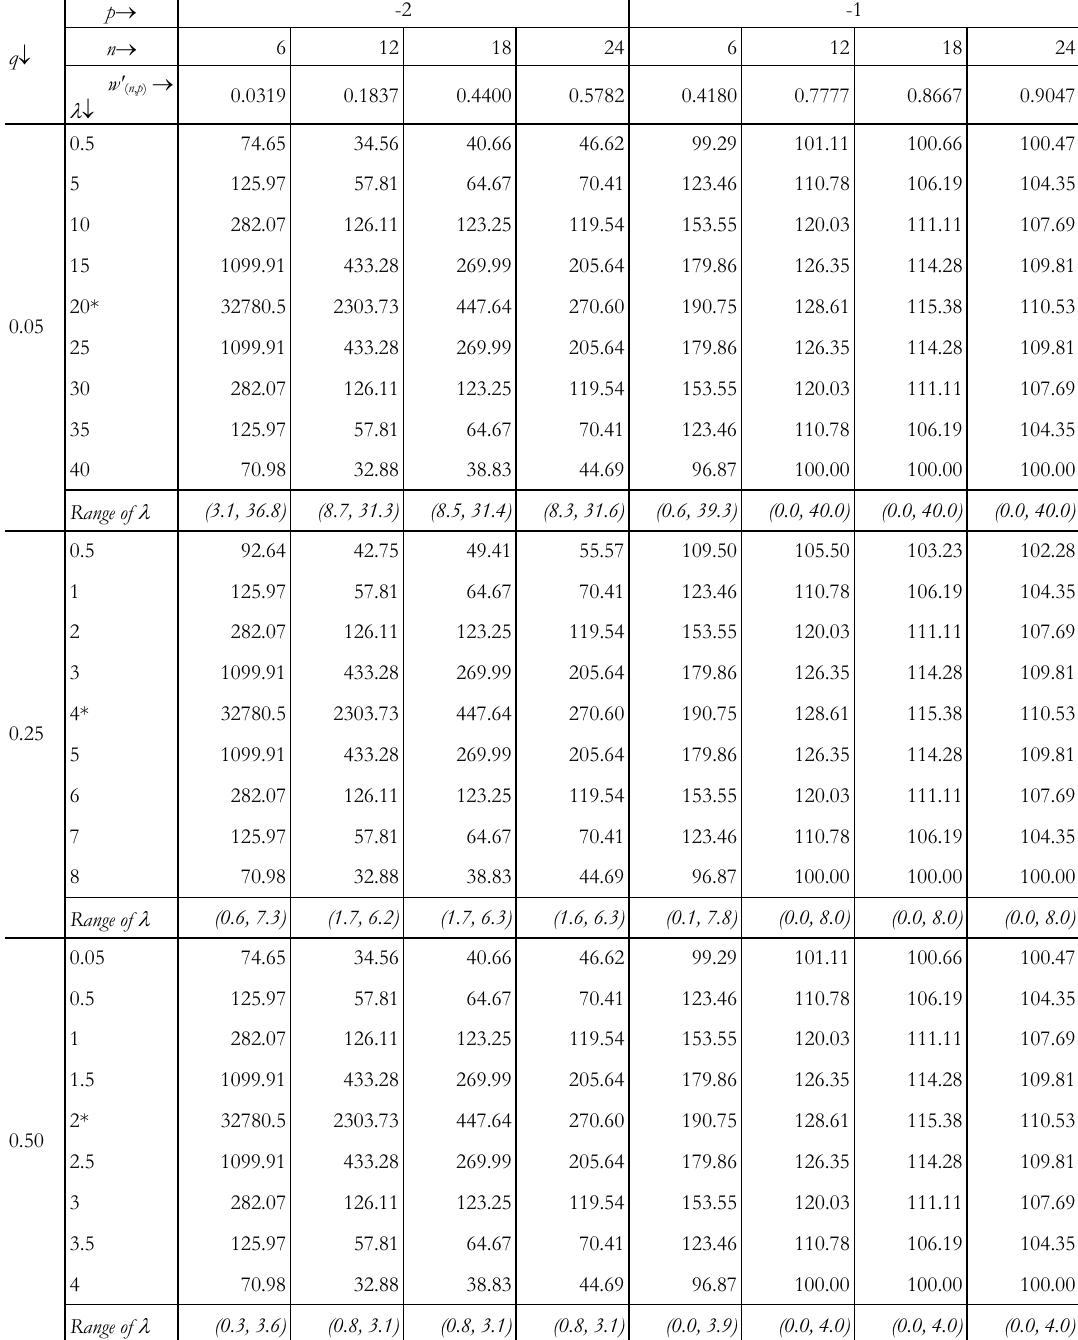
ˆ (cid:84) with respect to MMSE Estimator ˆ p q ( , )